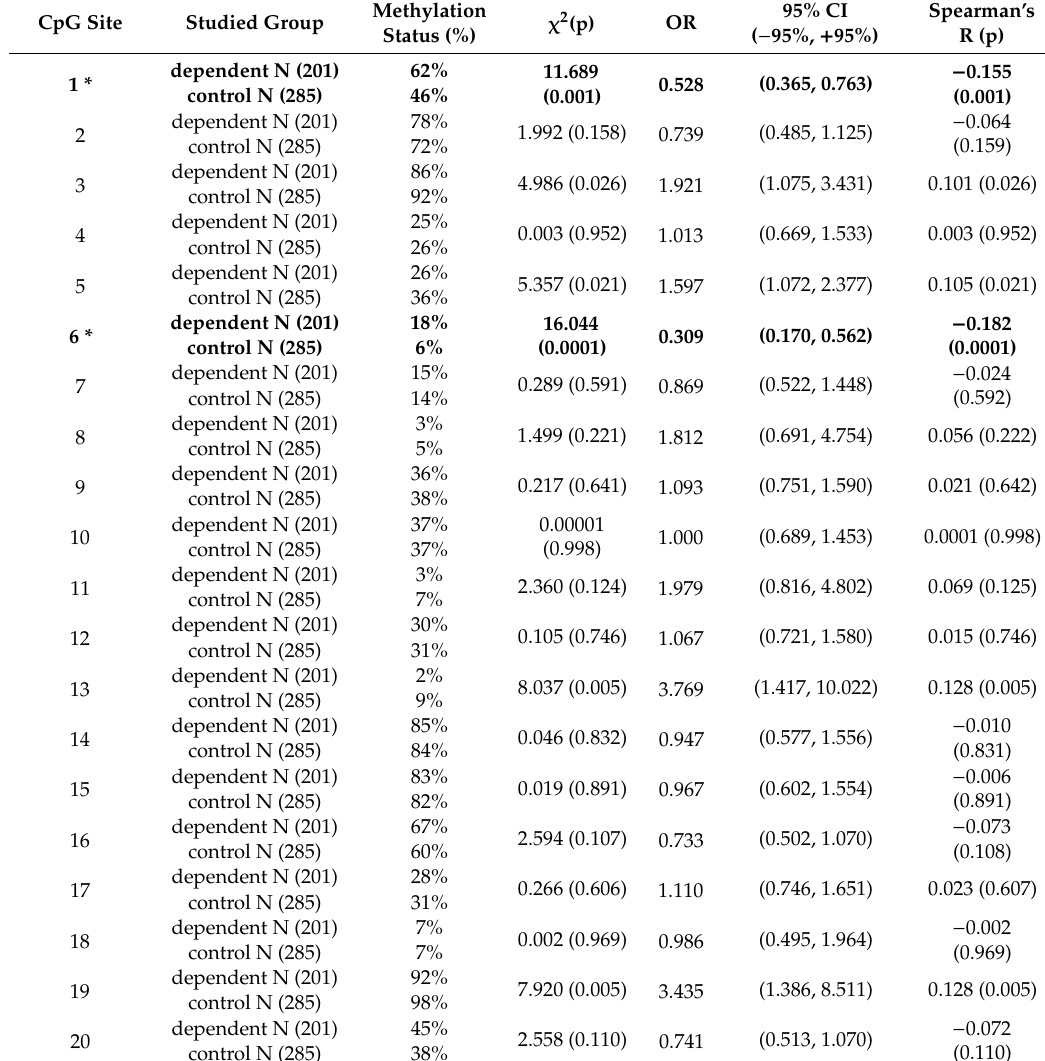
Table 1. The methylation status of 33 DAT1 CpG sites in cannabis-dependent and control